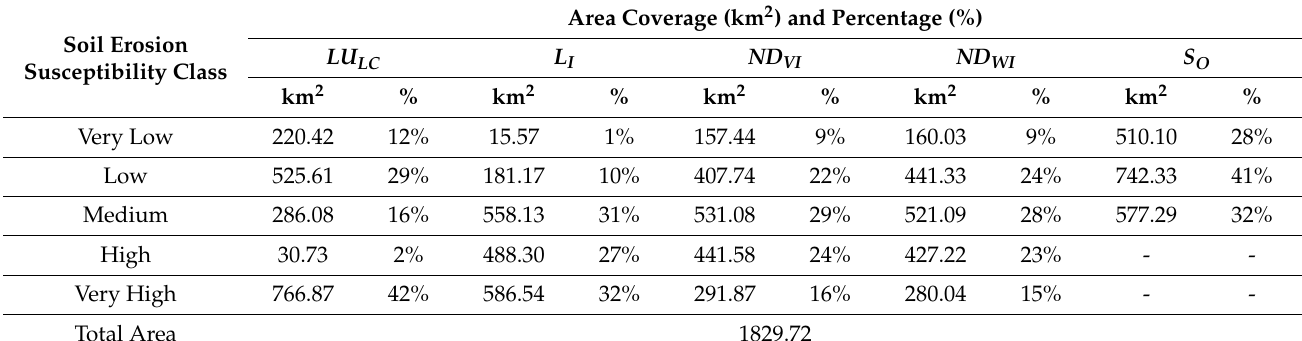
Table 7. Percentage distribution of LULC, lithology, NDVI, NDWI, and